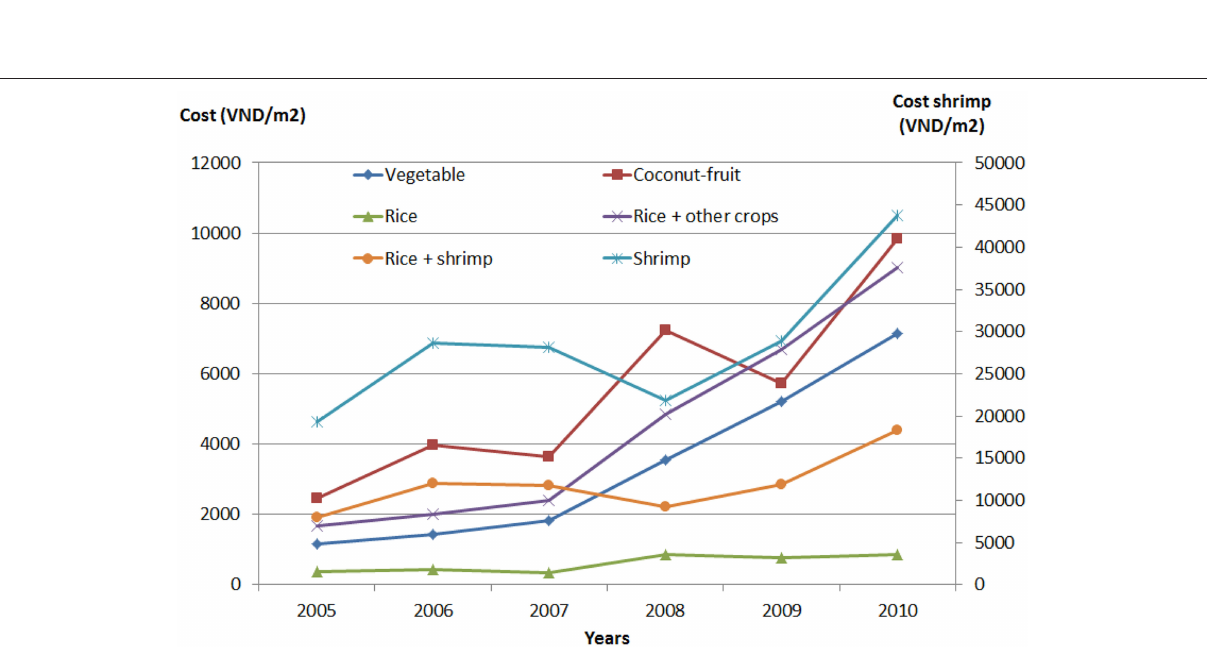
Frontiers in Environmental Science |